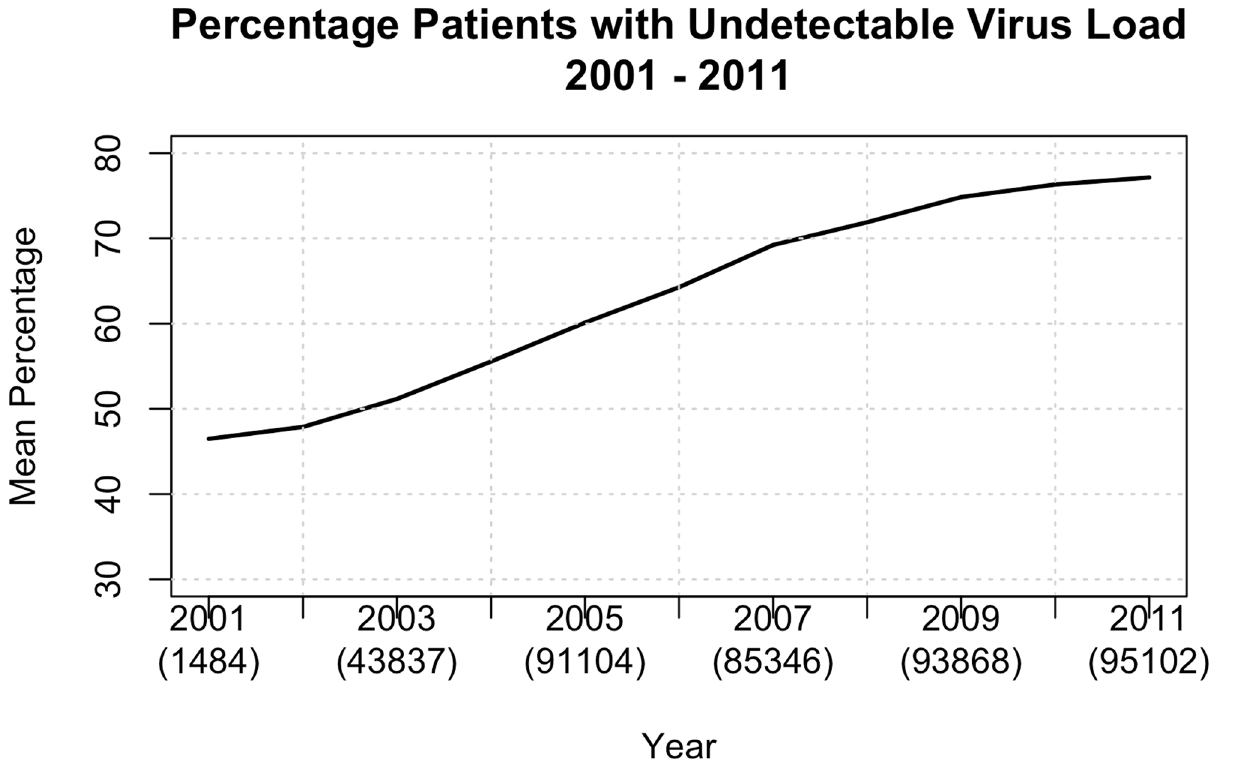
Fig 5. Viral loads below detection limit. Percentage of viral loads below detection among all individuals on antiretroviral treatment by age from 2001 to 2011.